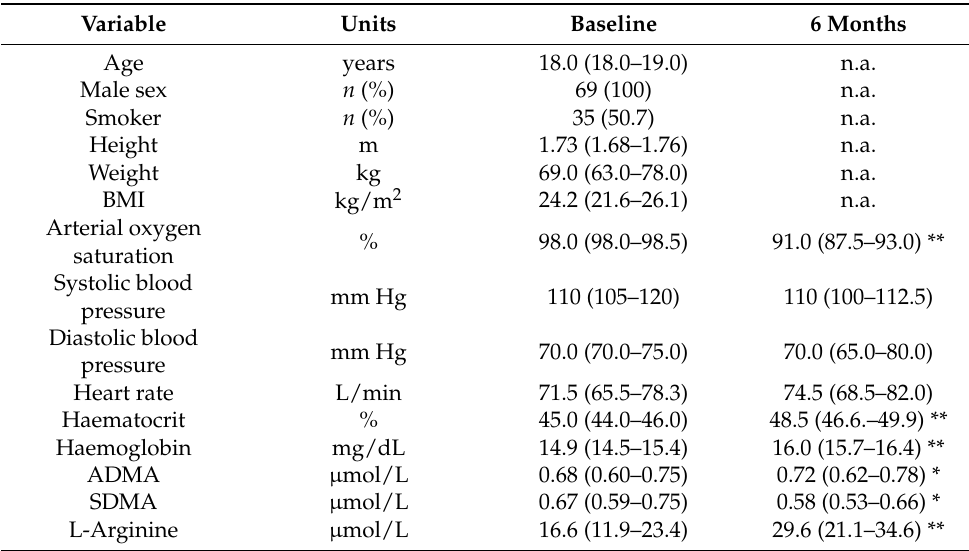
Table 1. Baseline characteristics of the study participants and effect of chronic intermittent hypoxia on selected